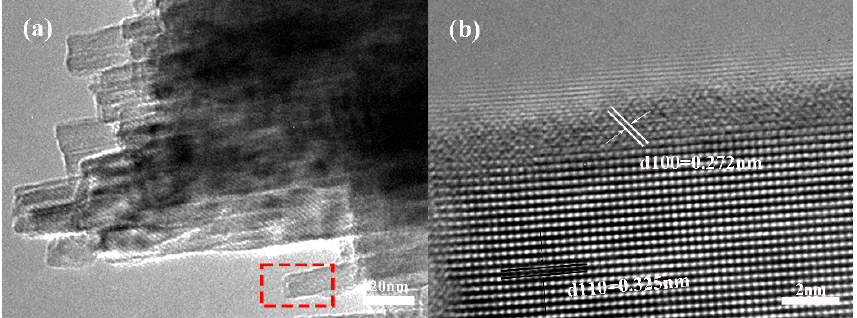
Figure 2. ( a ) TEM image of nanowire bundles; ( b ) HRTEM image of a single TiO 2 @SrTiO 3 heterostructured nanowire.